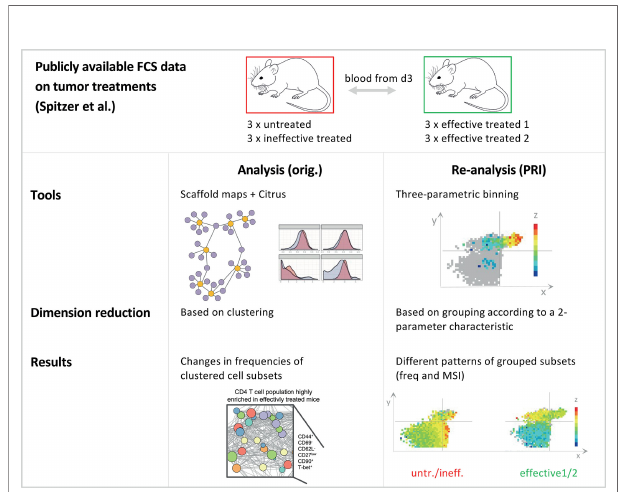
FIGURE 1 | Schematic comparison of the analysis approach with the re- analysis approach. Comparison of the analysis approach of Spitzer et al. (14) and the re-analysis of the data with PRI. Both studies analysed the same publicly available datasets on tumor treatments, while our re-analysis was limited to blood samples from day three from mice. For this dataset, there were a total of four different treatments, which can be divided into the two groups effective and ineffective. Within the ineffective treatment group there were animals that received no treatment (untreated - untr.) and those that received an ineffective (ineff.; anti-PD-1) treatment. In addition, there were effective treatment1 (effective 1; IFN- g + anti-CD40 + CD1-allo-IgG) and effective treatment2 (effective 2; IFN- g + anti-CD40 + B6-allo-IgG). For details on the experimental setting see Spitzer et al. The original analysis used common tools in fl ow cytometry, such as scaffold maps and citrus as well as clustering to reduce dimensions. As a result, the authors found changes in the frequencies of clustered cell subsets. In our bin-based re-analysis (PRI approach) we found different patterns and properties of grouped cell subsets concerning frequencies and MSI (mean signal